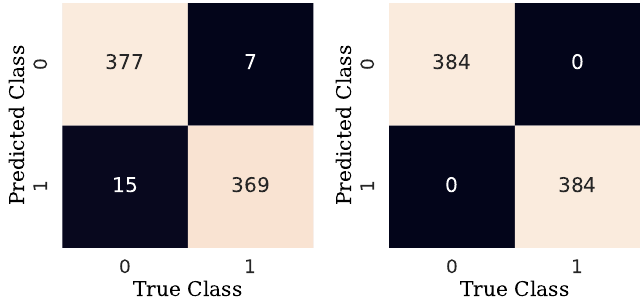
Figure 18. Confusion matrices for damage diagnosis models 1 ( left ) and 2 ( right ) when using a data split of 70% training, 15% validation, and 15% for testing.